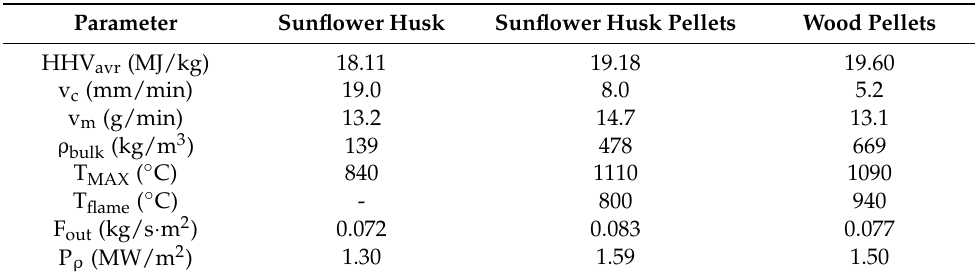
Table 2. Parameters of the operation of the batch combustion reactor using sunflower husk, sunflower husk pellets, and hardwood